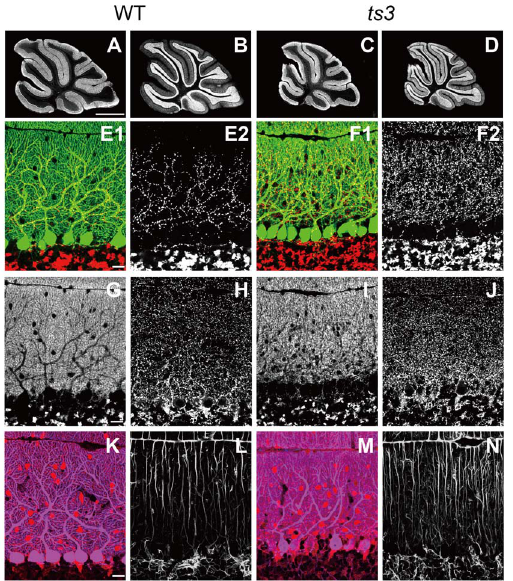
Figure 7. Distal expansion of CF territory in ts3 mutants. (A-N) Immunofluorescence for calbindin (A, C, green in E, F, blue in K, M), VGluT2 (B, D, red in E, F), VGluT1 (G, I), VIAAT (H, J), parvalbumin (red in K, M) and GFAP (L, N) in control (A, B, E, G, H, K, L) and the ts3 mutants (C, D, F, I, J, M, N). Note that VGluT2-positive CF terminals are markedly increased in number and distributed throughout the molecular layer in ts3 mutants (E, F). Scale bars, A, 1 mm; E, G, K, 20 m m.